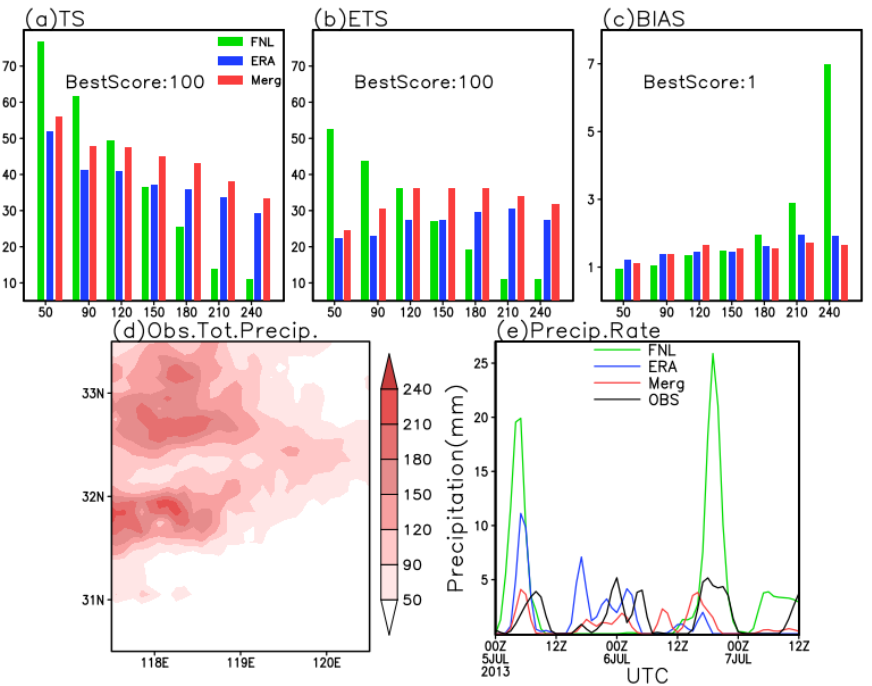
Figure 9. Comparison of the total precipitation and the precipitation rate and the observation. ( a – c ) The skill scores of total precipitation (units: %); ( d ) observed total precipitation (units: mm); and ( e ) precipitation rate (units: mm).